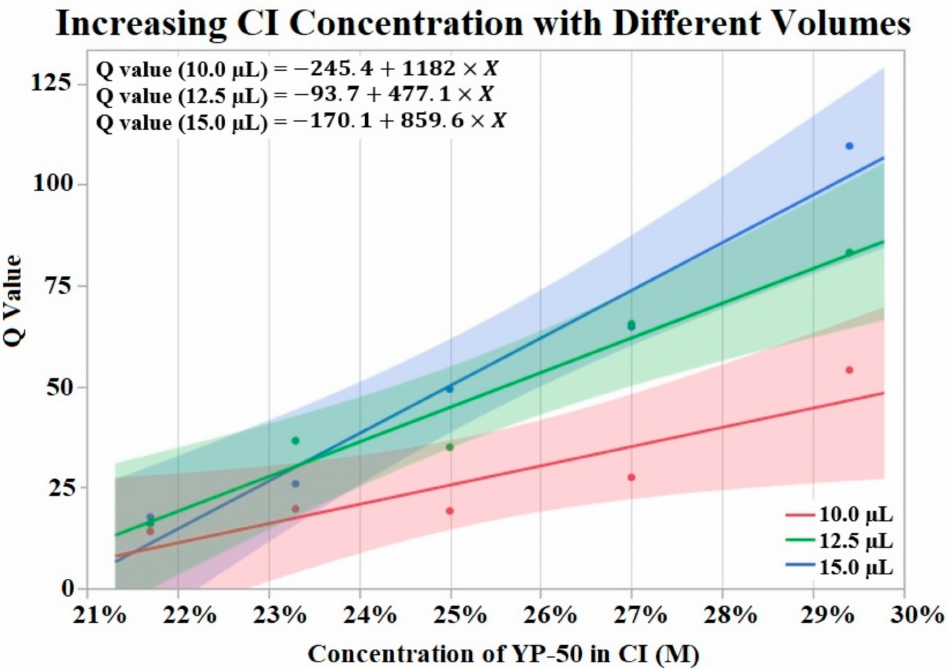
Figure 3. Fifteen CI electrodes were fabricated at different CI concentrations and volumes (indi- cated as red, green and blue). The molarity of activated carbon was calculated for each electrode concentration. An upward trend in Q value is shown for increases in concentration. α =